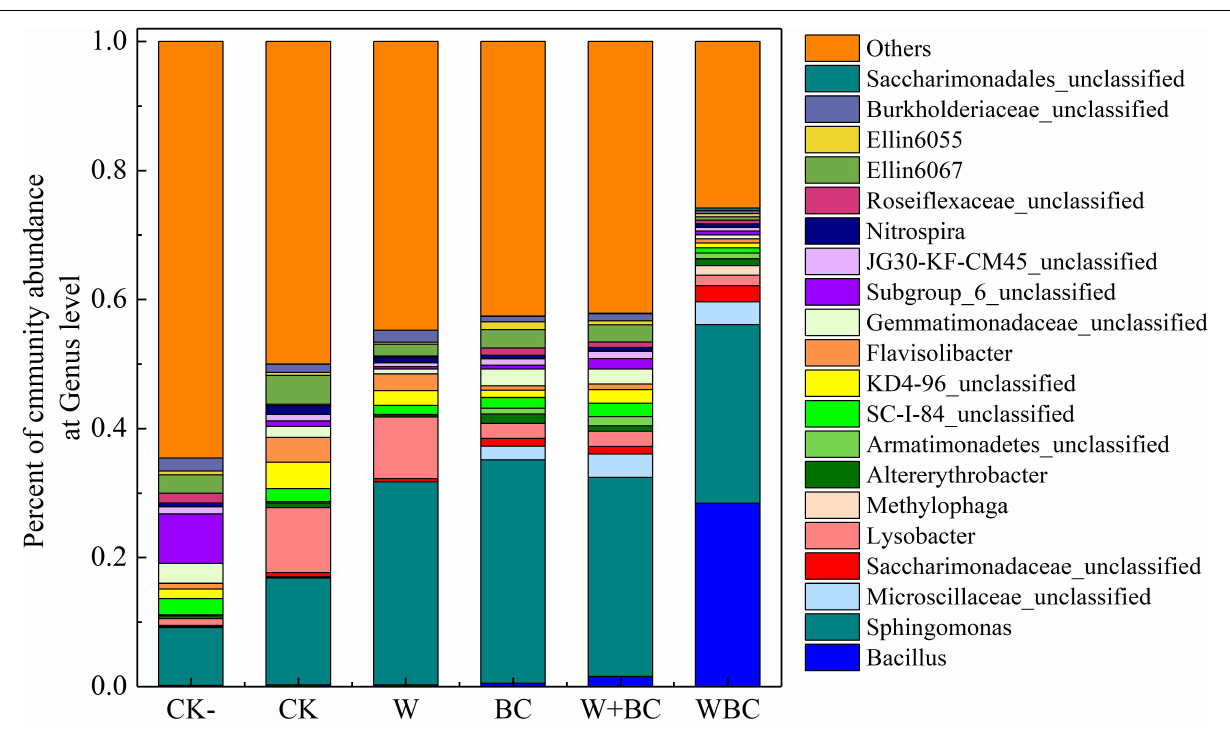
FIGURE 4 | Microbial structure of soil with different remediation methods. Effects of different remediation methods on soil microbial abundance at Genus level.